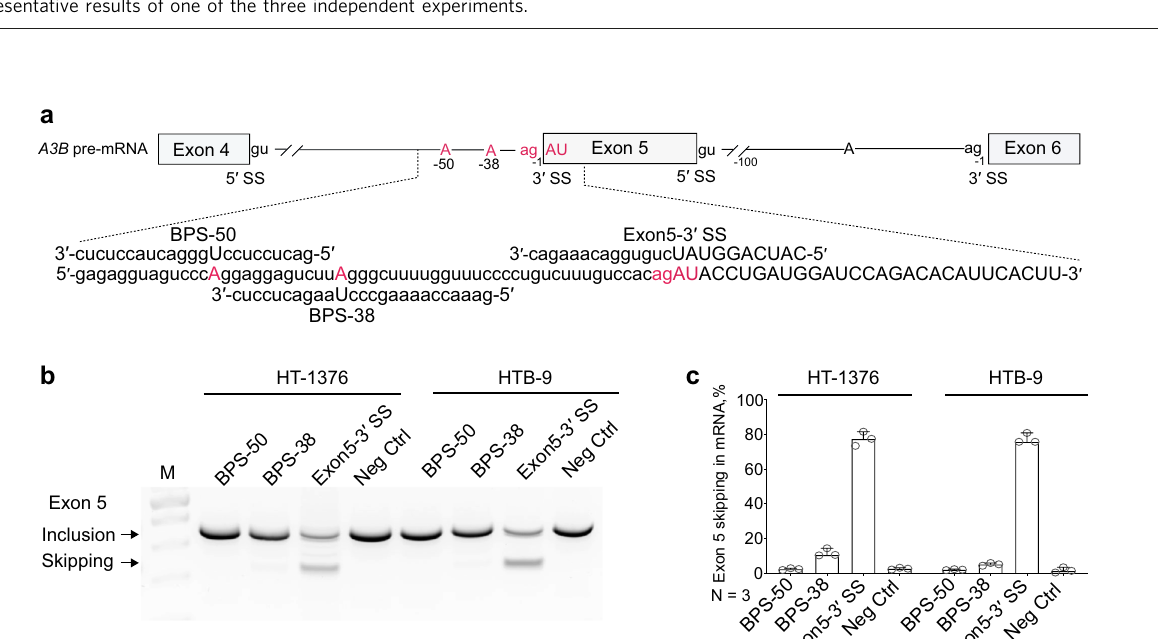
Fig. 6 Modulation of A3B exon 5 skipping by an SF3B1 inhibitor pladienolide B. a Schematic representation of the A3B splicing module (exon 4 – exon 6) featuring interactions between trans -factors of the spliceosomal machinery with splicing cis -elements: splice sites (SS), branch point sites (BPS), polypyrimidine tract (Py), and exonic splicing enhancers/silencers (ESE)/(ESS); possible outcomes of A3B exon 5 splicing resulting from interactions between SF3B1 and other spliceosomal proteins with weak versus strong BPS. b Schematic representation of the hypothesis depicting that inhibition of SF3B1 is expected to result in skipping of A3B exon 5 and downregulation of A3B1 protein. c PCR analysis of splicing patterns of A3B exons 5 and 6 using Exontrap mini-genes E5 BPS + and E6 BPS + in HT-1376 cells treated for 36 h with increasing concentrations of pladienolide B. Exon 5 skipping is increased in the presence of the SF3B1 inhibitor, while splicing of exon 6 is not affected. d Results of qRT – PCR in HT-1376 cells treated with increasing concentrations of pladienolide B for indicated time points show splicing shift from A3B1 to A3B3 . Shown are means ± SD of biological triplicates. e Western blot protein analysis of HT-1376 cells treated with increasing concentrations of pladienolide B for 36 h showed downregulation of A3B1 protein, while expression of endogenous A3B3 protein was not detected. f RT-PCR analysis of exon 5 splicing representing A3B1 and A3B3 transcripts in HT-1376 cells treated with DMSO (vehicle), digoxin (an NMD inhibitor), pladienolide B alone, and pladienolide B with digoxin. A3B3 mRNA levels are increased in digoxin-treated cells due to its inhibition of NMD. g Deamination assays using whole-cell extracts from HT-1376 cells treated with bleomycin and pladienolide B. Equal amounts of total protein were used for each reaction based on densitometry pre-assessment of GAPDH protein levels in each sample. Deamination was observed in reactions with protein lysate of HT-1376 cells treated with bleomycin alone or bleomycin plus 1 nM of pladienolide B. Higher concentrations of pladienolide B (10, 20, 40, and 100 nM) reduced A3B1 levels and prevented deamination of the ssDNA probe in bleomycin-treated conditions. A3B1 was barely detectable in DMSO and pladienolide B only conditions because of low total protein input in reactions (2 μ g of total protein lysate). h Separate experiment showing that pladienolide B (10, 20, 40, and 100 nM) suppresses induction of A3B by bleomycin. Western blot (WB) analysis with an anti-A3B1 antibody shows the amounts of A3B1 in corresponding reactions. Each lane was loaded with equal amounts of the whole-cell lysate (15 μ g of protein/lane). Shown are representative results of one of the three independent experiments.